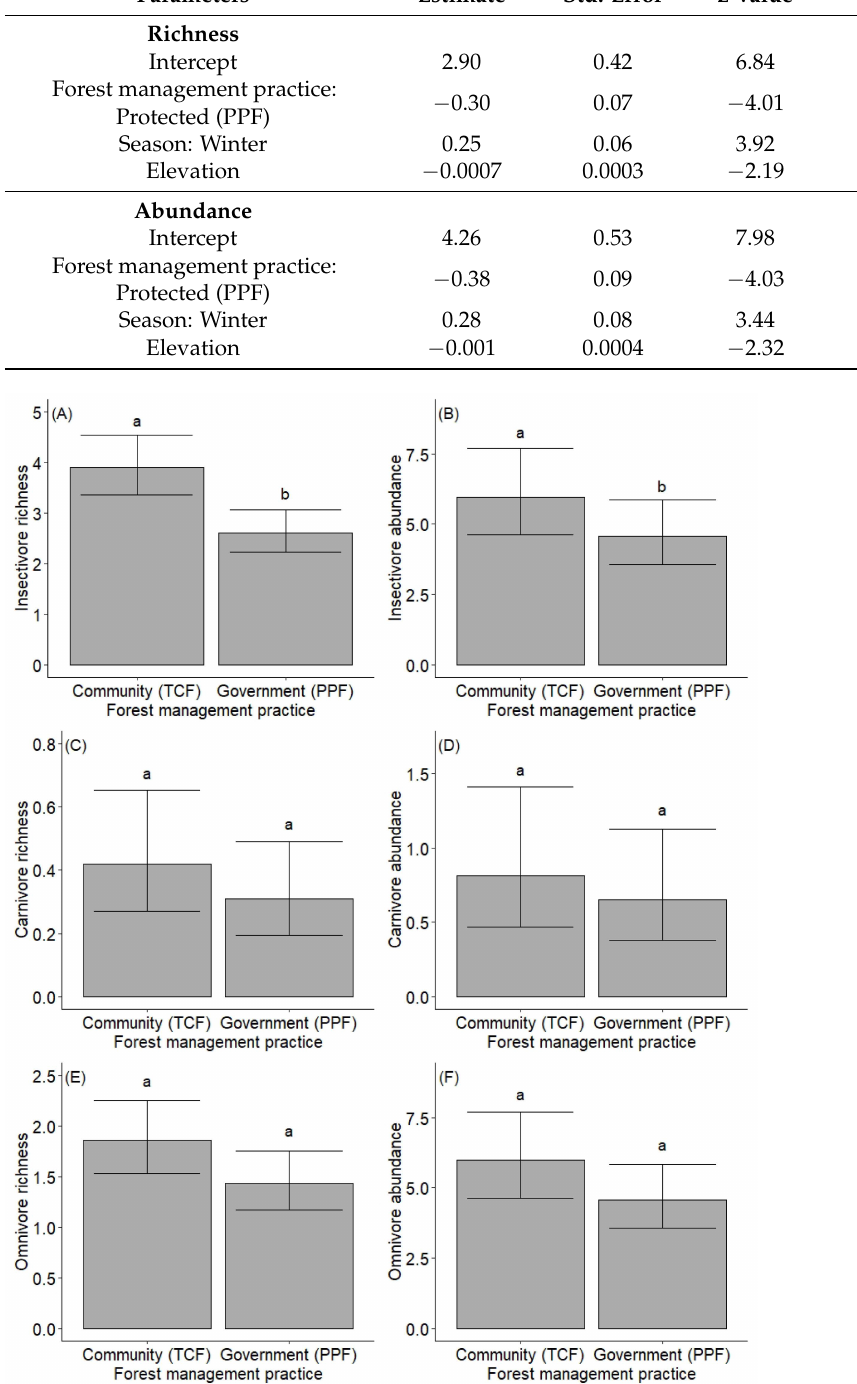
Figure 3. Predicted variation in bird feeding guild ( A , C , E ) richness and ( B , D , F ) abundance by forest management practice. The forest management practices are protected forest (Panchase Protection